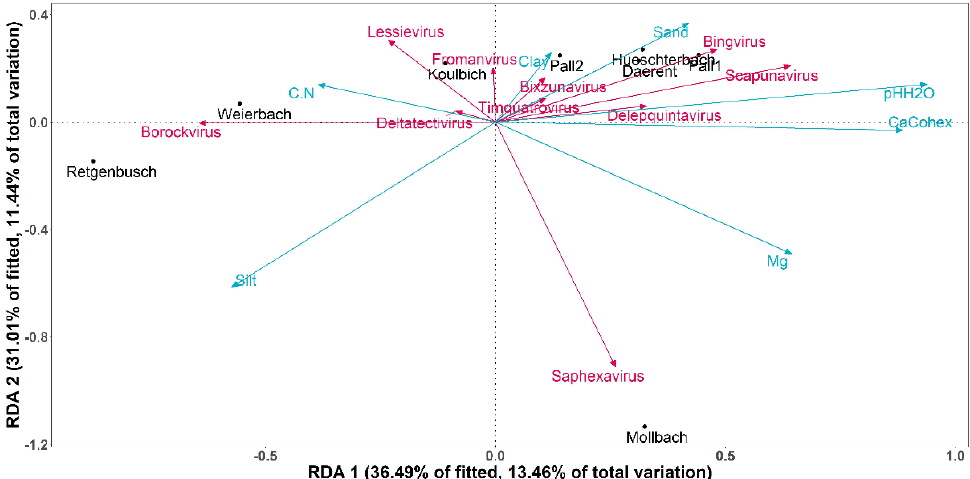
Figure 4. Biplot of redundancy analysis (RDA) on the 10 most abundant genera of DNA bacteriophage in relation to the soil properties of each site. The pink vectors represent the DNA bacteriophage genera with a Hellinger transformation, the blue vectors display the selected soil properties and the sites are shown in black. The RDA was built over the two first dimensions, with 36.49% of the fitted variations explained by RDA1 and 31.01% by RDA2. (C.N = carbon to nitrogen ratio; Mg = magnesium concentration; pHH 2 O = soil pH measured in water, CaCohex = calcium cation